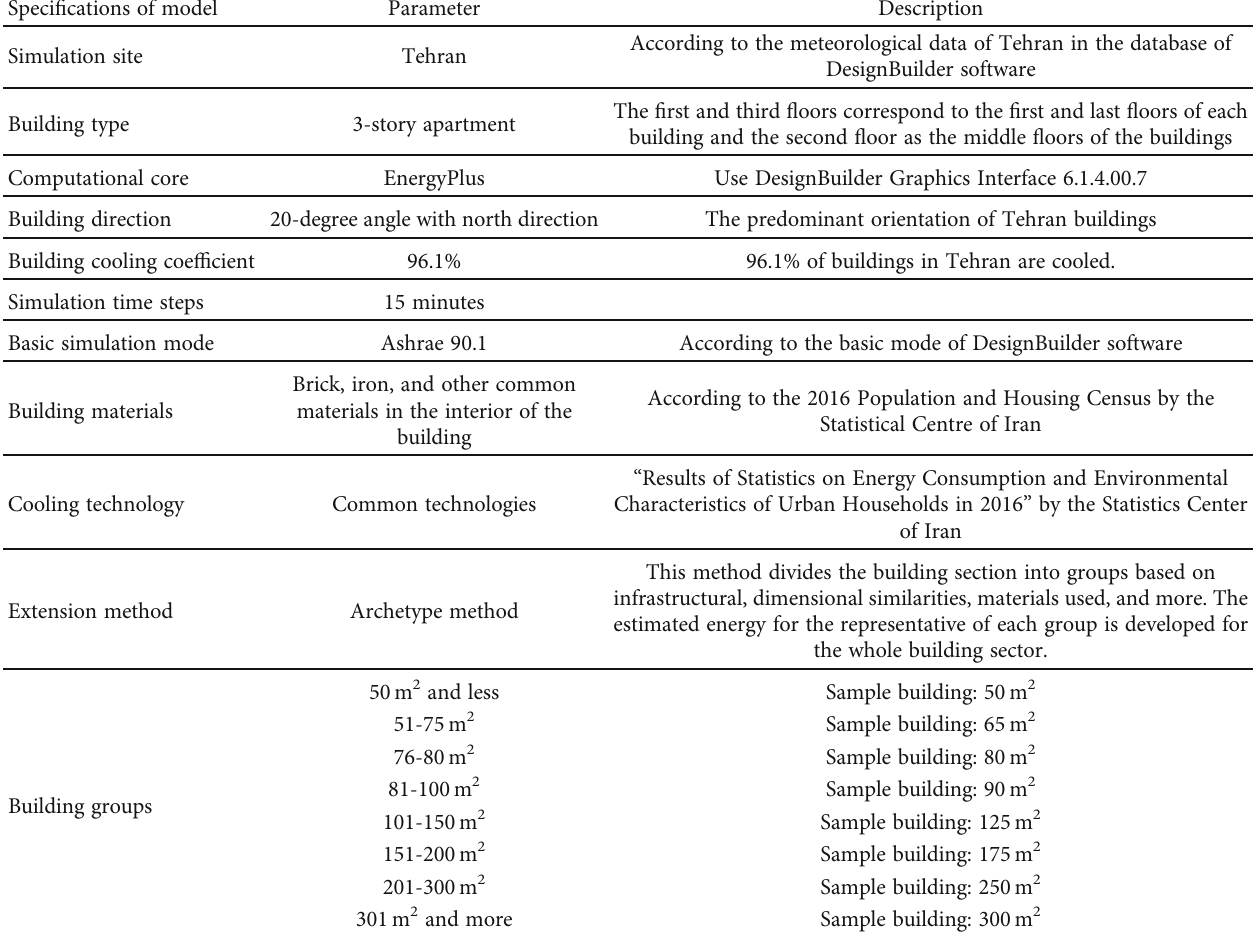
Table 9: Speci fi cations of the bottom-up